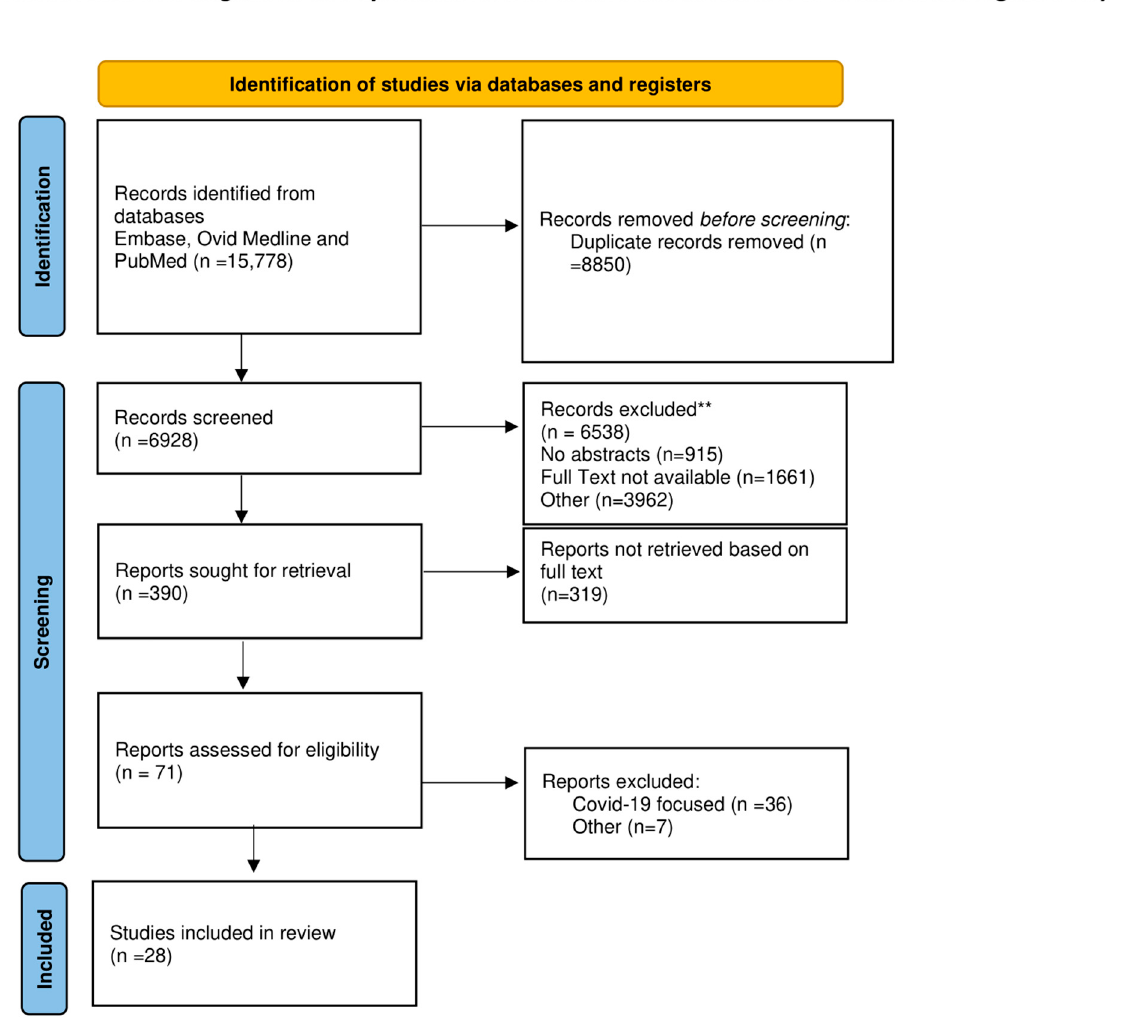
Figure 1. The PRISMA 2020 statement: an updated guideline for reporting systematic reviews. For more information, visit http://www.prisma-statement.org/ (accessed on 15 January 2023).